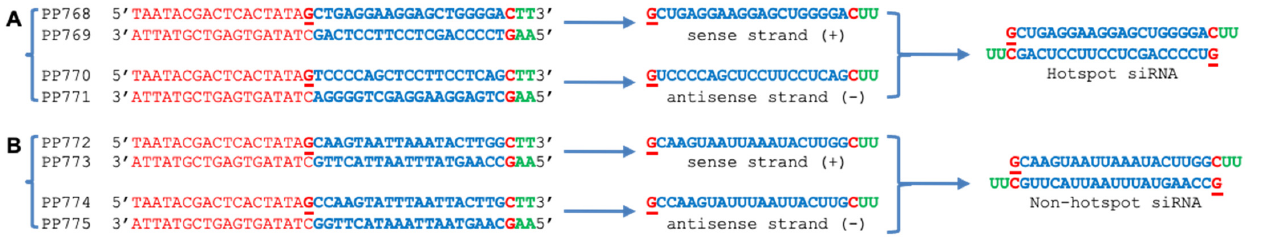
Figure 1. Design of ACMV siRNA. ( A ) hotspot siRNA. ( B ) Coldspot siRNA. Hotspot siRNA sequences in ACMV DNA-A start from 1440 to 1458 nt whilst coldspot siRNA sequences in ACMV DNA-A start from 1341 to 1359 nt on the viral complementary strand of ACMV DNA-A. T7 promoter-bearing oligonucleotides were annealed to form double-stranded templates for in vitro transcription to synthesise sense (+) and antisense ( − ) strands of small RNAs. The (+) and ( − ) RNA strands were complemented to produce siRNAs. T7 promoter is indicated red, siRNA blue and 3 ′ -UU overhang green. The transcription start nucleotide is underlined. Notably, genome regions in which no or few vsiRNA is detectible are defined as “coldspot”. On the other hand, regions to which a large number of vsiRNAs can be mapped are regarded as “hotspot”. Hotspot and coldspot vsiRNAs were identified by bioinformatics analyses of the “454” sequencing data sets.